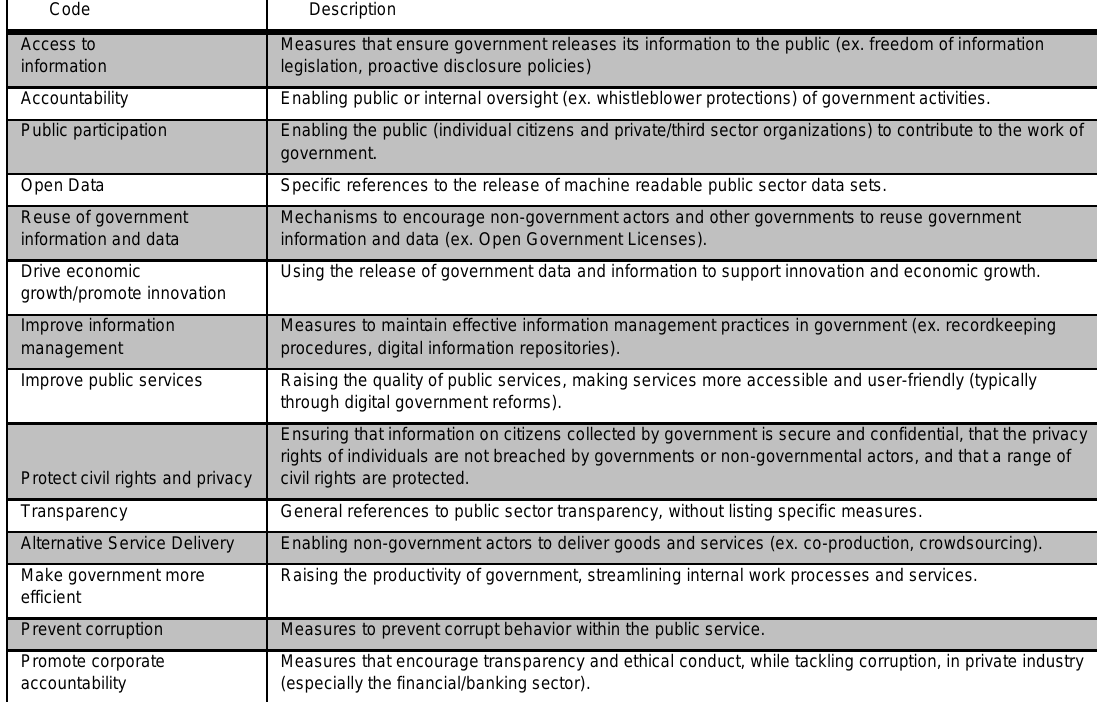
Table 1: Descriptions of codes included in the codebook Code